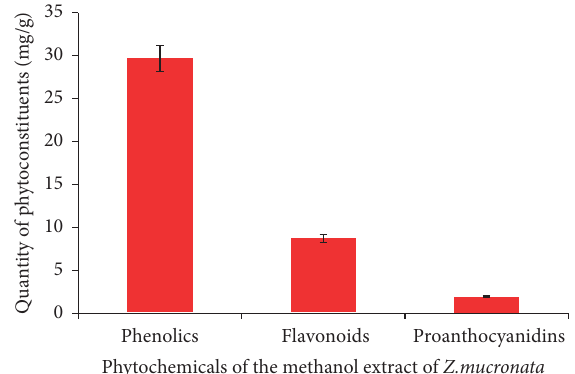
Figure 1: Quantity (mean ± SD) of phytochemicals in the meth- anol extract of Z. mucronata Table 2. The in vitro 50% inhibition concentration (IC values obtained for the DPPH inhibition of ZMM, BHT, and ascorbic acid were found to be 0.043 ± 0.02, 0.042 ± 0.03, and 0.040 ± 0.02 mg/mL, respectively.